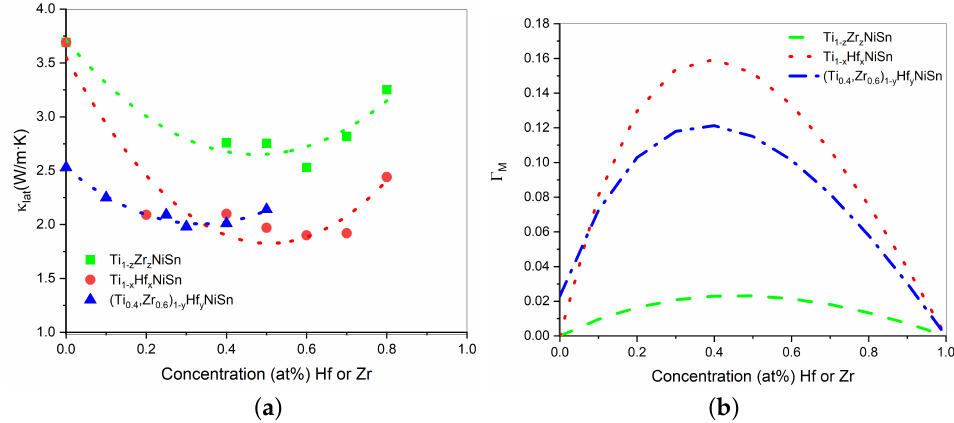
Figure 10. ( a ) Room temperature lattice thermal conductivity of all series and previous work (the doted lines are a guide for the eye), ( b ) Calculated mass fluctuation parameter of all